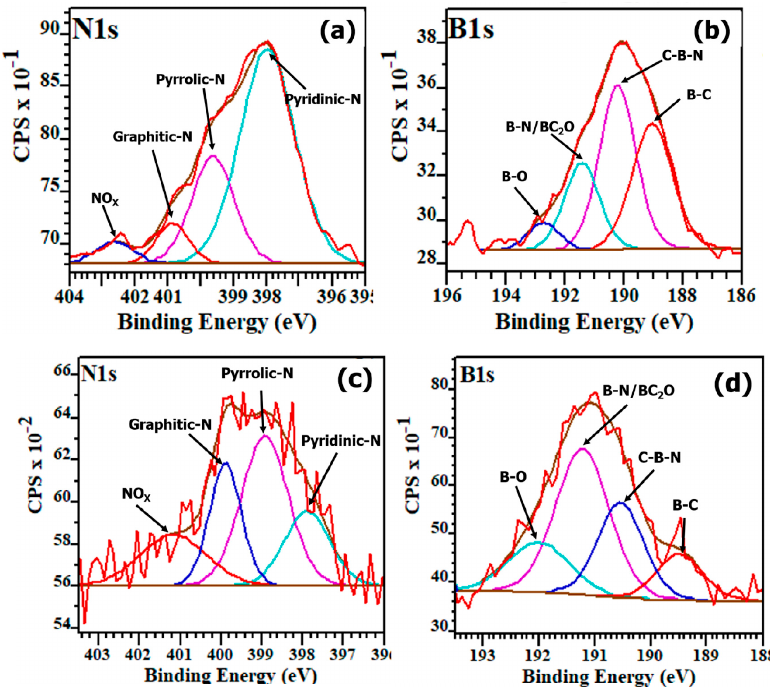
Figure 4. XPS spectra showing deconvoluted N1s and B1s peaks of the; ( a , b ) BN-CSs and ( c , d ) activated BN-CSs.